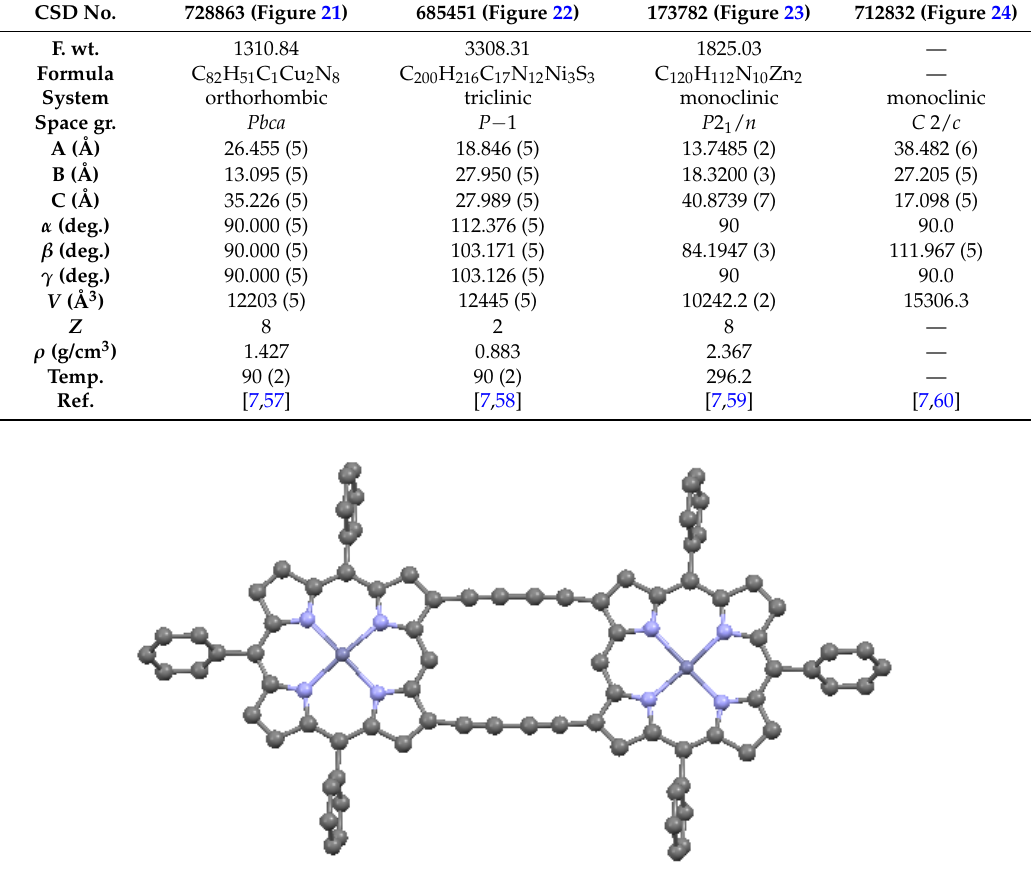
Figure 17. A doubly β -to- β 1,3-butadiyne-bridged TPP-based dimer, from data in [7,53]. Each zinc has one axially bound isopropanol ligand. Each phenyl ring has two tert -butyl groups at 3,5 positions. Solvates and peripheral groups are omitted in this and the following diagrams as necessary for clarity. Dark blue = Zn.